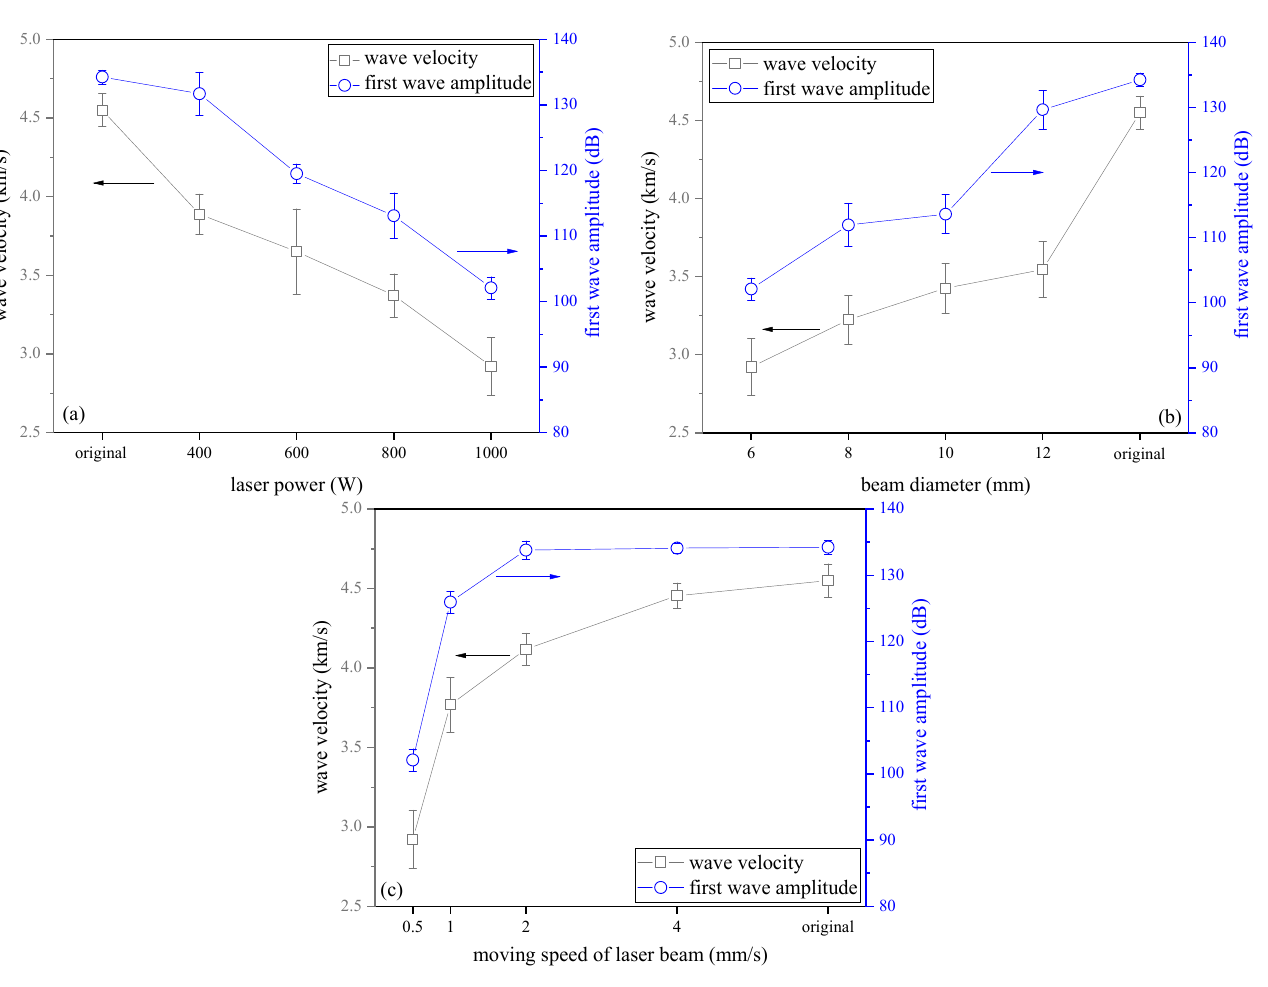
Figure 6. The influence of ( a ) laser-power output, ( b ) beam diameter, ( c ) moving speed on wave velocity and first-wave amplitude.